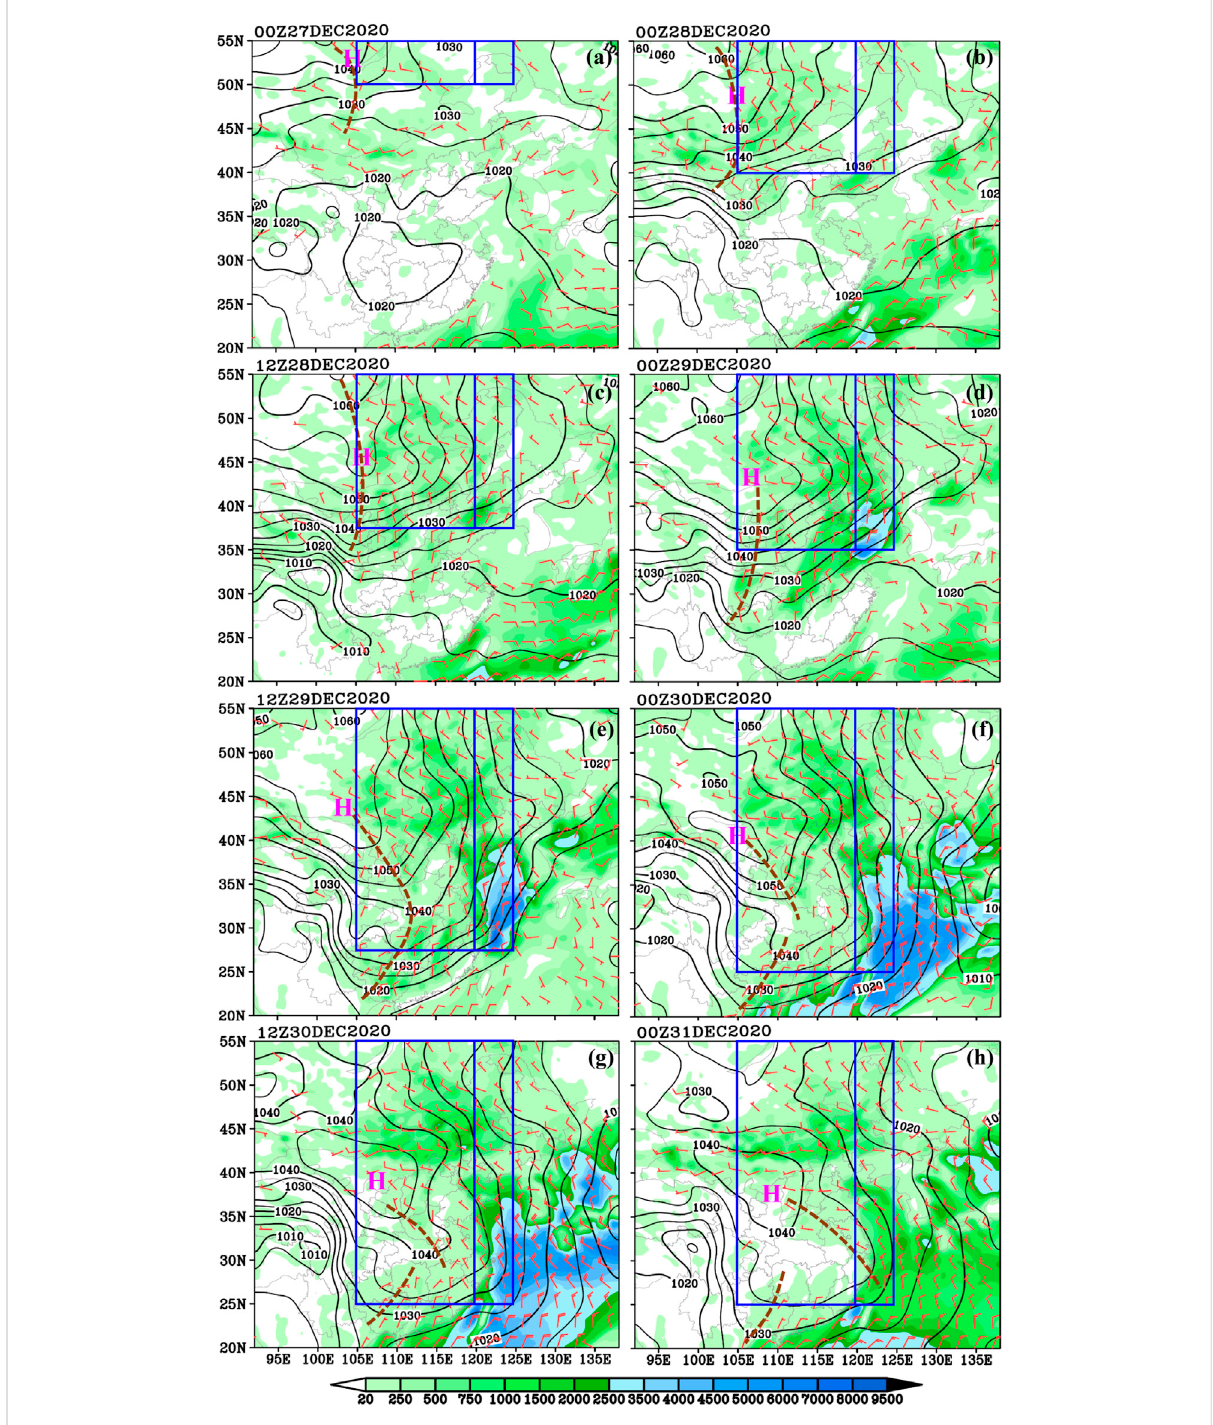
FIGURE 11 Wind power density (shading; W m − 2 ) and wind speed > 4 m s − 1 (full bar = 4 m s − 1 ) at 100 m above the ground level. ‘ H ’ = high-pressure system. Brown dashed lines = ridge lines. Blue boxes = FR1 and FR2 of the cold wave